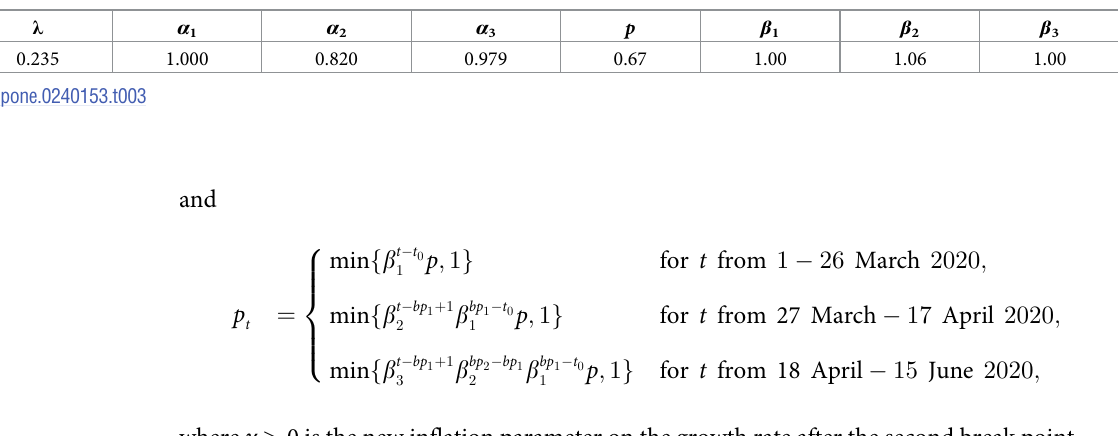
Table 3. MLE of parameters.